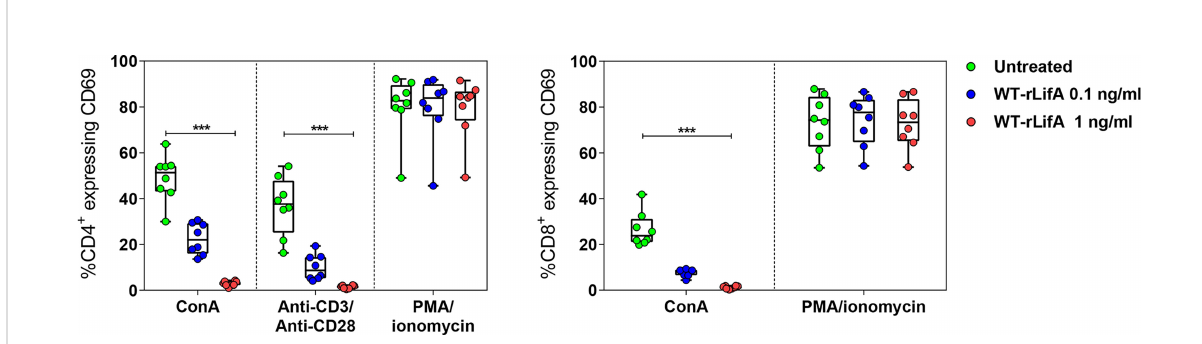
FIGURE 5 Lymphostatin suppresses CD69 expression in anti-CD3/anti-CD28 or ConA-stimulated CD4 + and CD8 + T cells. Box and whisker plots show the percentage of CD69 expression on anti-CD3/anti-CD28, ConA, and PMA/ionomycin-stimulated CD4 + T cells and ConA and PMA/ionomycin- stimulated CD8 + T cells treated with WT-rLifA, or left untreated (cells with mitogen; no tested protein). Data represent the mean from 8 healthy donors. Symbols with circles represent data from the mean of technical replicates for each of the 8 donors. *** p < 0.001 using Kruskal-Wallis test followed by Dunn ’ s test.